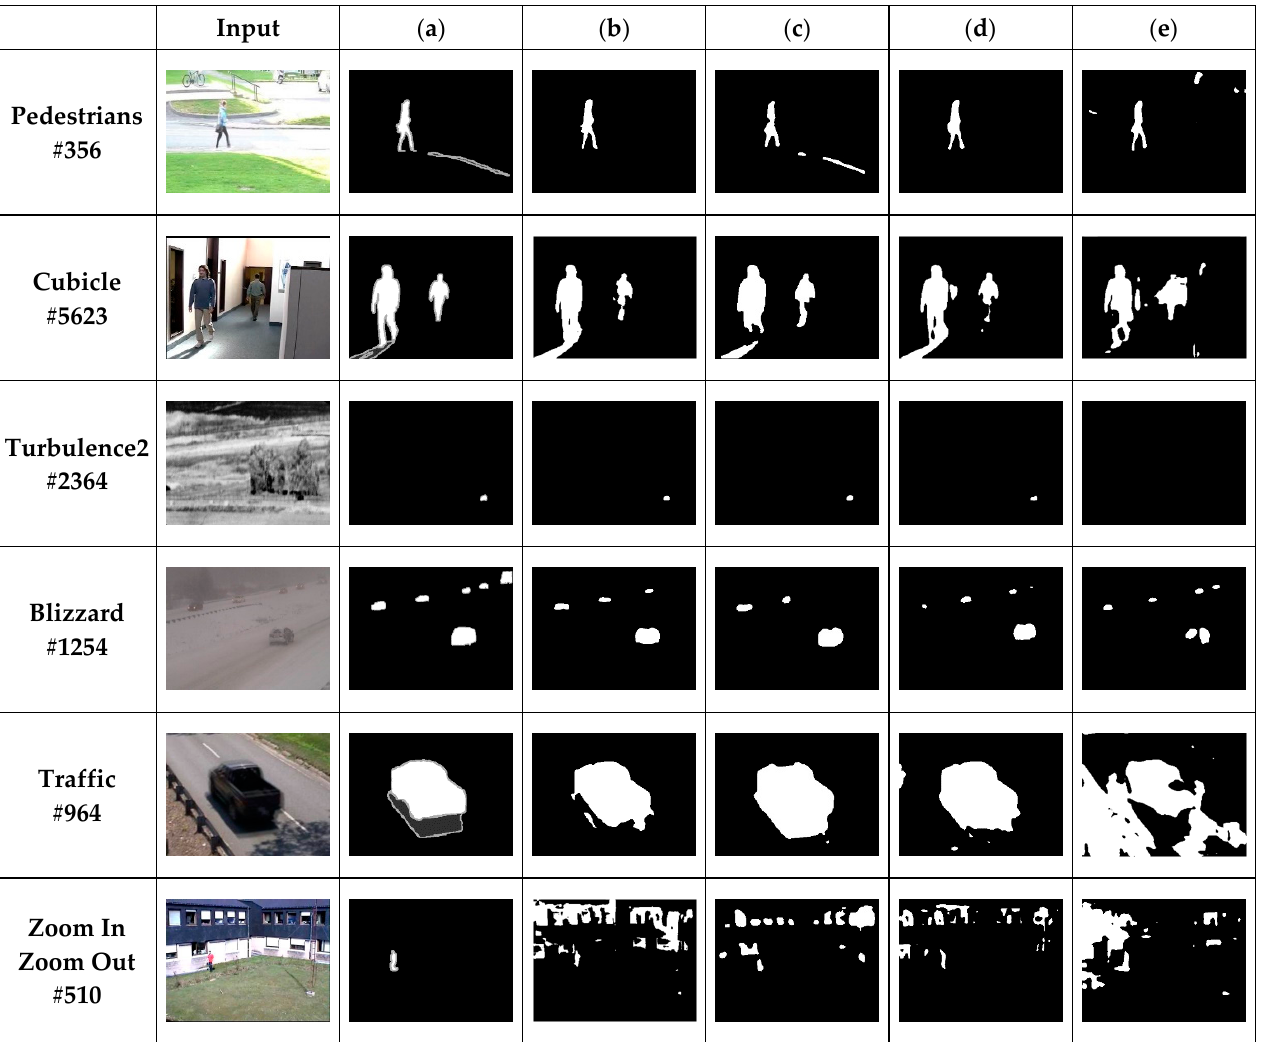
Figure 5. Test results obtained on scenes not used for training in the CDnet 2014 dataset: ( a ) ground truth foreground maps, ( b ) proposed method, ( c ) SuBSENSE [2], ( d ) modified FgSegNet-v2, ( e ) FgSegNet-v2 [42]. Table 8. Comparison of FM score by the proposed method and other algorithms on the SBI2015 dataset.